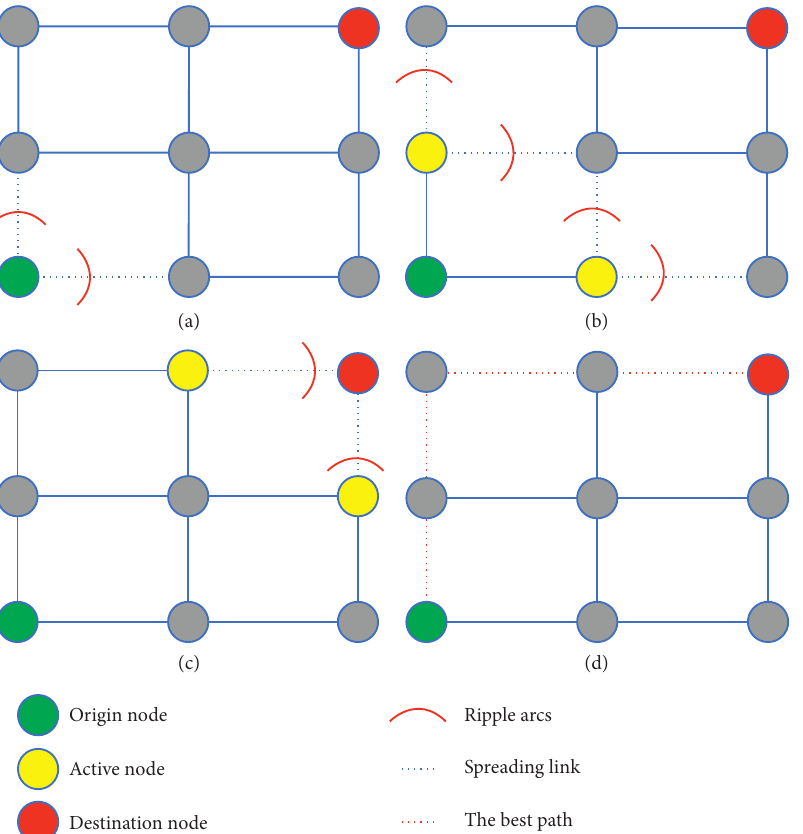
Figure 2: The illustration of an independent ripple relay race.